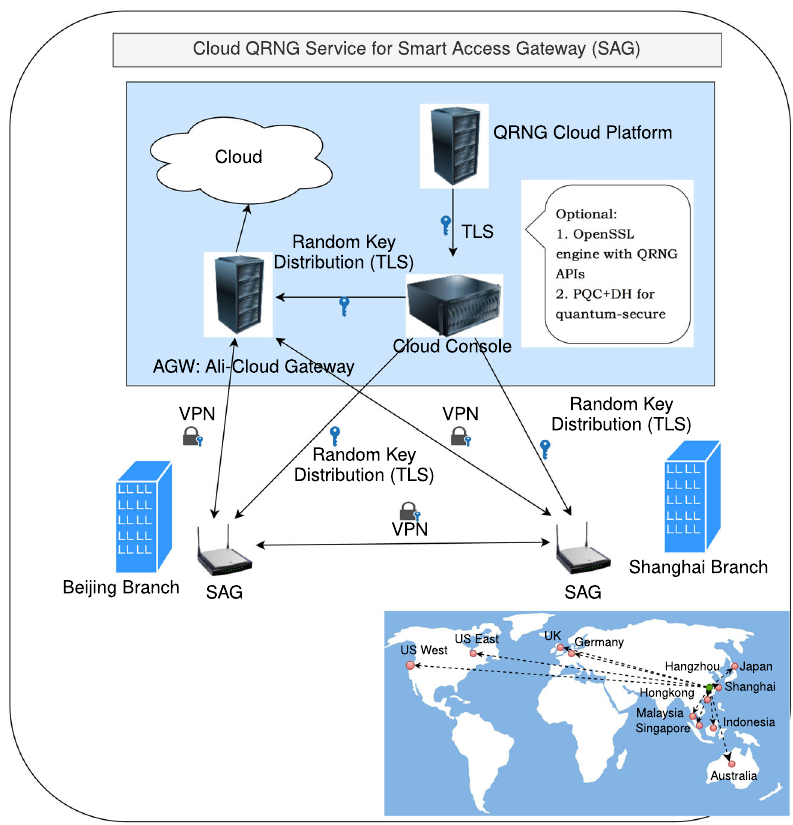
Fig. 4 QRNG service worldwide. Smart Access Gateway QRNG Cloud Implementation.